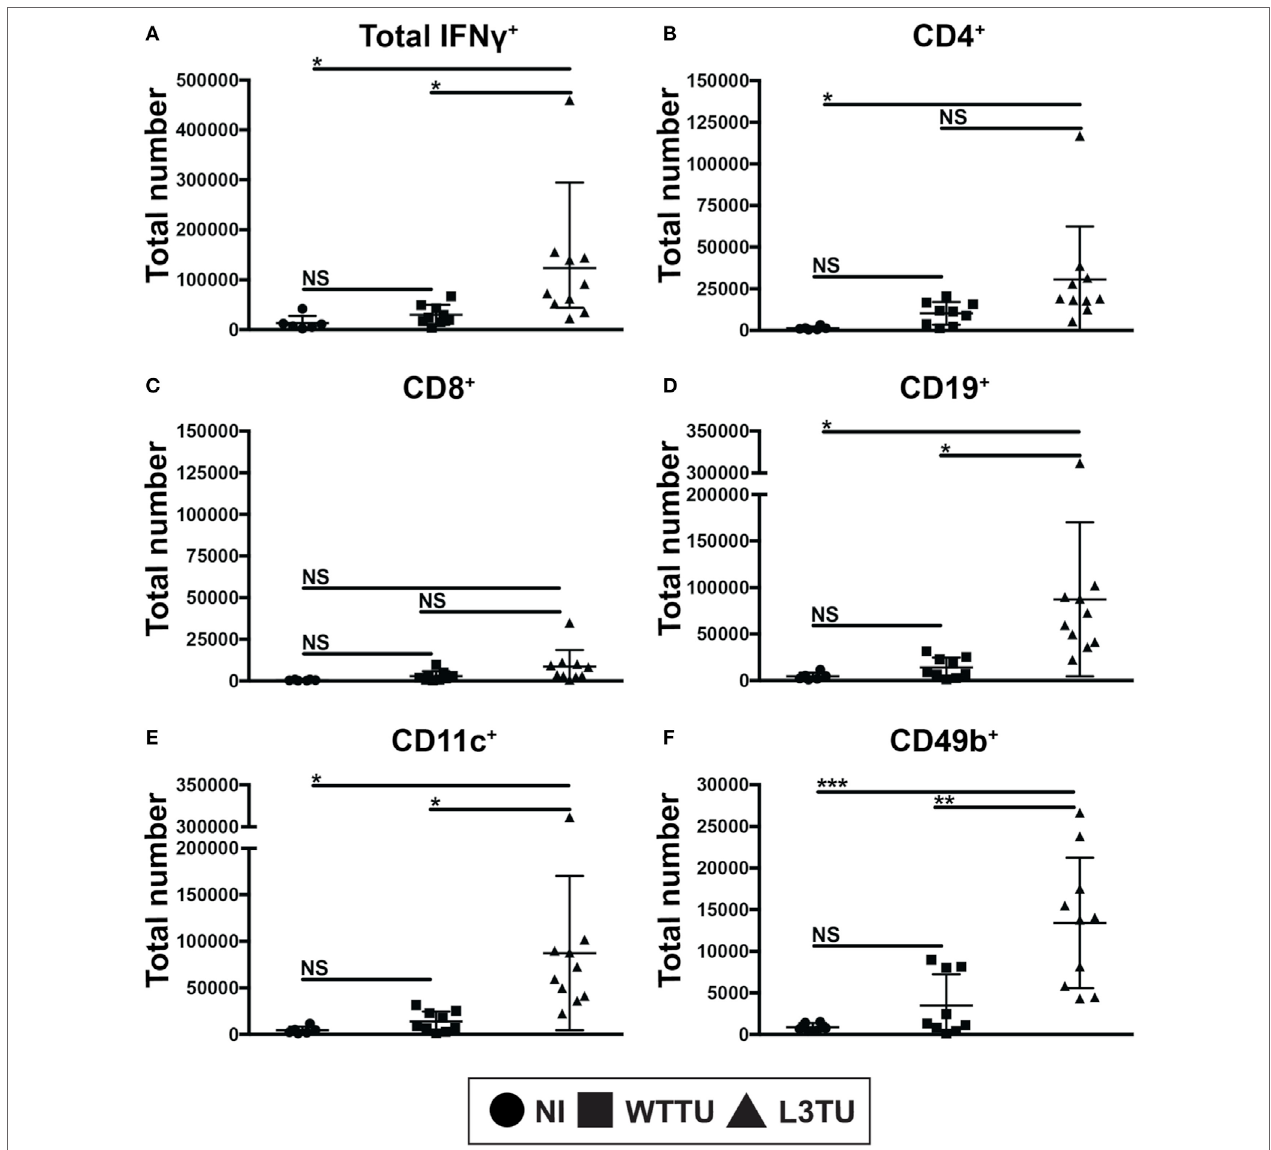
FigUre 3 | aCCL3 enhances the accumulation of IFNg+ cells in the TDLN. Absolute numbers of (a) IFNg+ total immune cells, or IFNg+ immune cells expressing (B) CD4, (c) CD8, (D) CD19, (e) CD11c, and (F) CD49b in the TDLN on day 5 following tumor inoculations were measured by FACS. N = 4–10 mice per group with two repeats. Not significant, ns; p > 0.05, * p = 0.01–0.05, ** p = 0.001–0.01, *** p = 0.0001–0.001, **** p <